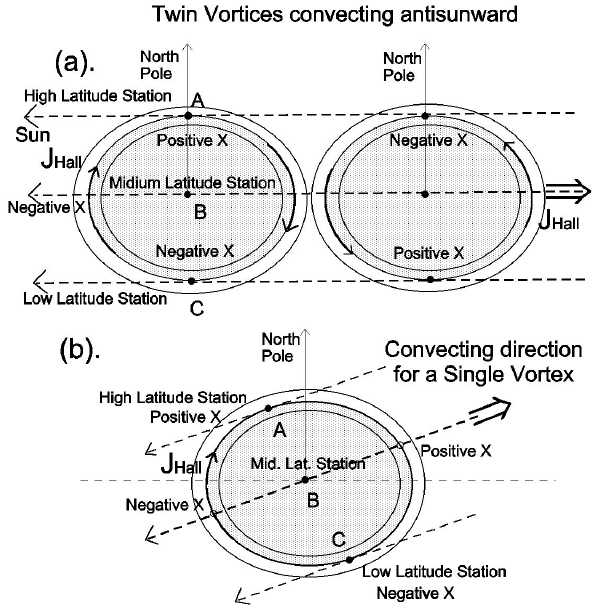
Fig. 14. ( a ) Twin vortex current system with opposite polarities of Hall currents moves antisunward above the IMAGE chain stations. Current flow is denoted with an arrow on each vortex structure, while the Sun is located to the left-side of this page. The high-(low- )latitude station labelled A (C) is representative of positions near the high-(low-)latitude edges of vortices. The station A records an NP excursion along the X-component magnetic field trace, while the station C records a PN excursion at the ground station C. The medium latitude station B will not detect any X-component varia- tion. ( b ) Single vortex structure of Hall current convects antisun- ward and poleward, and produces a positive (negative) monopolar feature at station A (C), and a PN-type bipolar feature at station